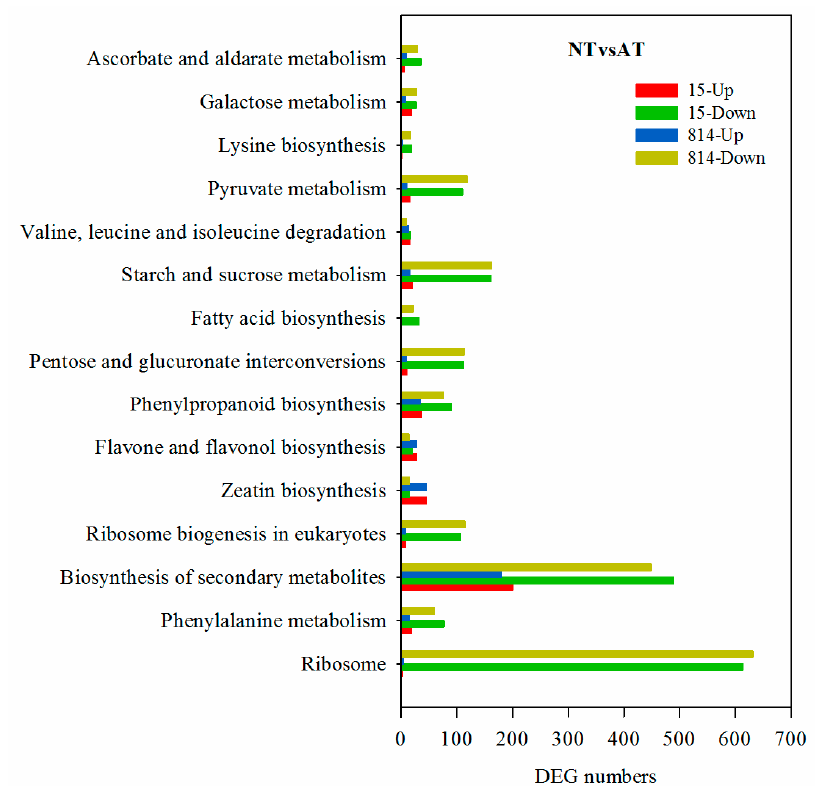
Figure 5. Top fifteen enriched Kyoto Encyclopedia of Genes and Genomes (KEGG) pathways for NTvsAT (15 and 814). The x -axis represents the number of DEGs involved in each pathway; the y -axis depicts pathways arranged from bottom to top based on the degree of enrichment.